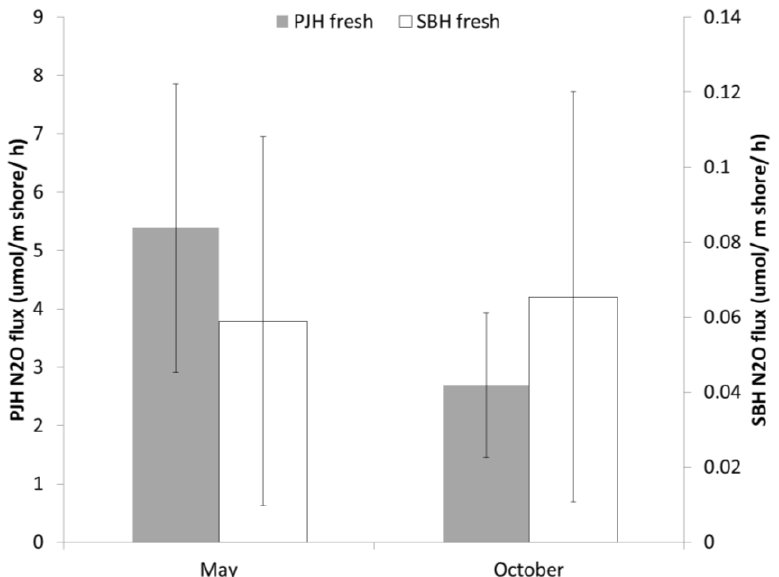
Figure 5. N 2 O flux from a fresh coastal aquifer (PJH) and a coastal aquifer containing an USZ (SBH). Error bars are calculated from the range of submarine groundwater discharge (SGD) flux measurements taken for each site during the respective time periods.